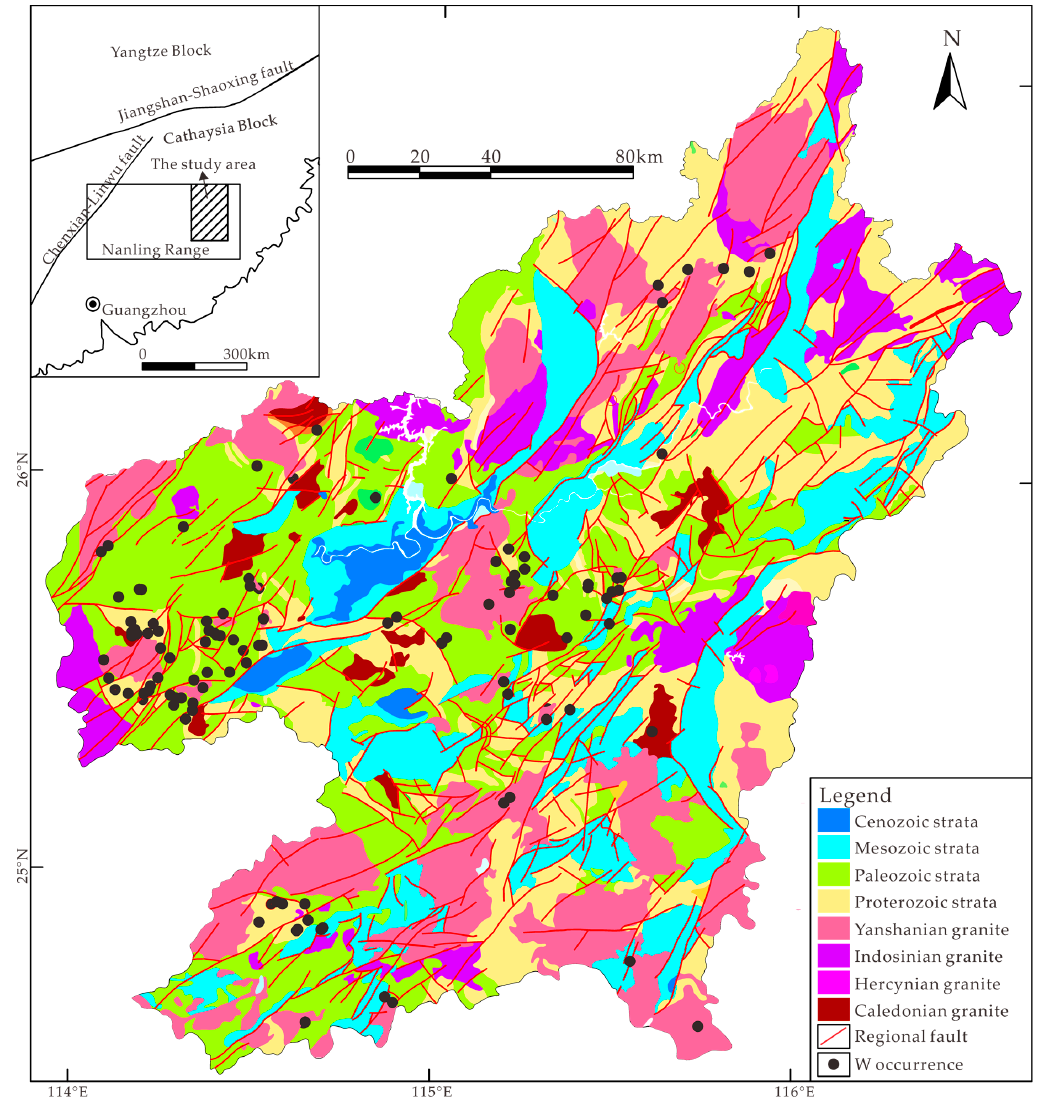
Figure 1. Simplified geological map of the study area, modified from [39,48,49]. Figure 2. Simplified geological map of the study area, modified from